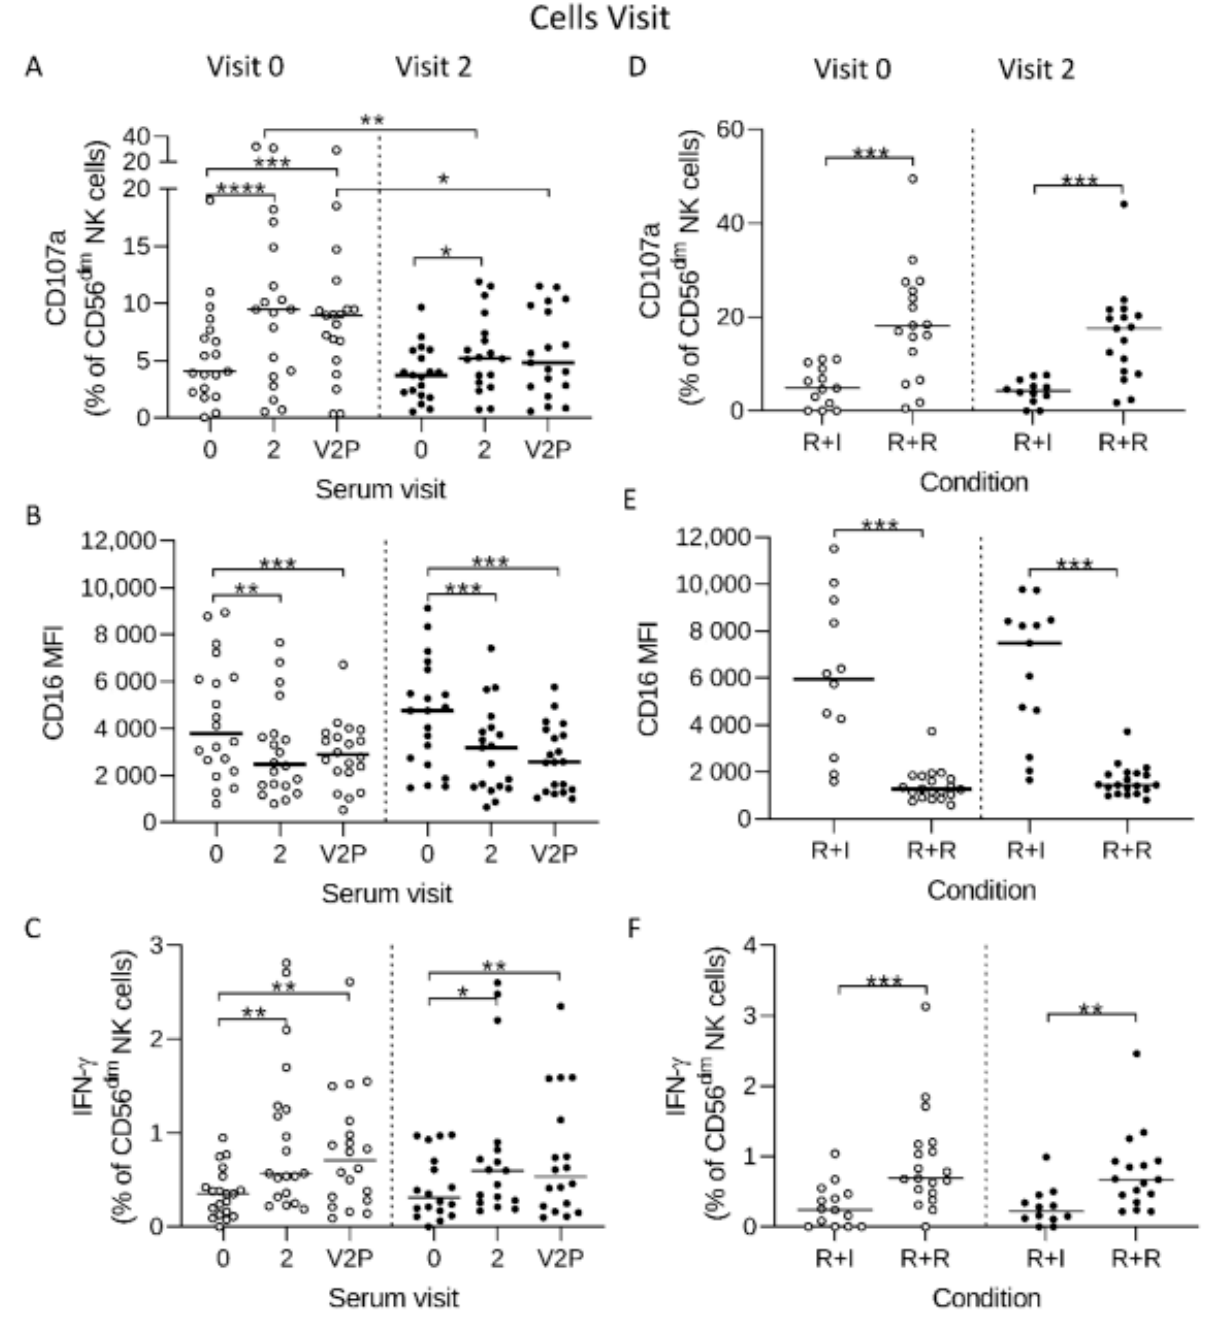
Figure 3. ADNKA responses of pre- and post-vaccination NK cells from individual trial participants using their autologous pre- and post-vaccination sera. PBMC collected pre-vaccination (Visit 0) and 21 days post-dose two (Visit two) were cultured with EBOV GP in the presence of autologous serum from the same visit or with pooled serum from all participants at Visit two (V2P) ( A – C ). Positive and negative control stimuli were Raji B cells + Rituximab™ (R + R condition) or isotype control antibody (R + I condition), respectively ( D – F ). Responses were analysed by flow cytometry for ( A , D ) CD107a, ( B , E ), CD16 mean fluorescence intensity (MFI) and ( C , F ) IFN- γ expression. Individual data points are shown for 18 participants tested in this assay with a line representing median values for all tested donors. Comparisons between visits were performed using one-way ANOVA mixed effects analysis with Geisser-Greenhouse correction. * p < 0.05, ** p < 0.01, *** p < 0.001. **** p < 0.0001.